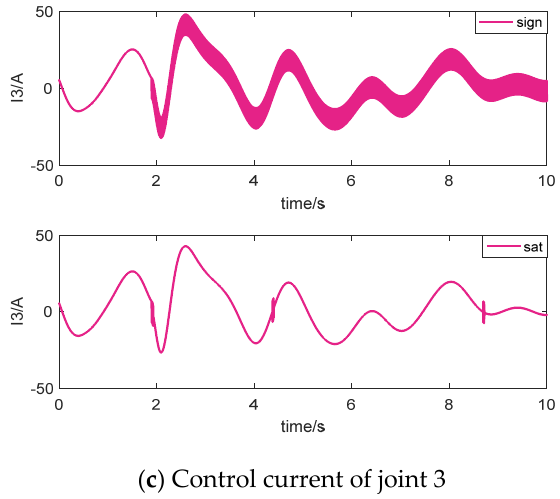
Figure 11. Control current comparisons with full payload and uncertainties.